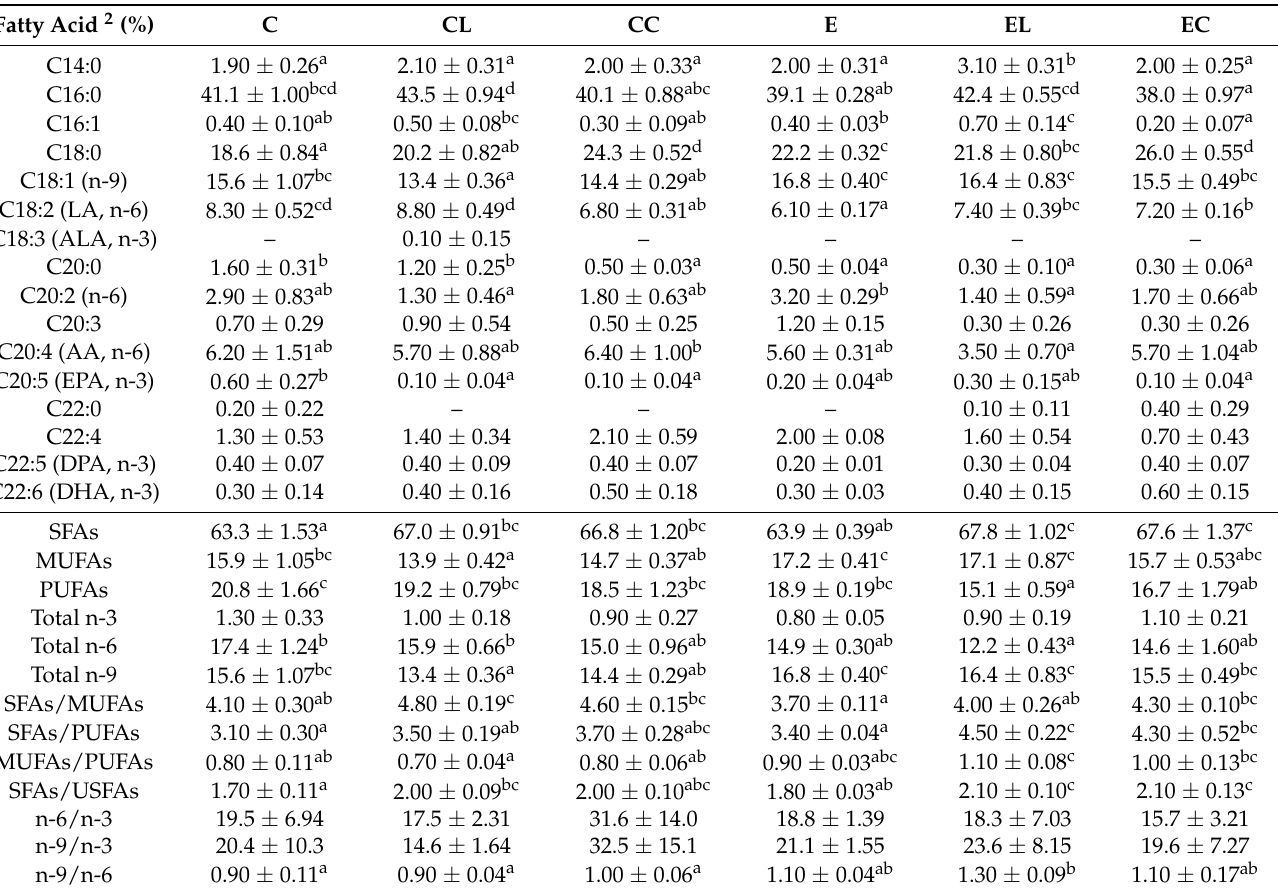
Table 11. Effects of different dietary fat sources on erythrocytic fatty acid composition in rats 1